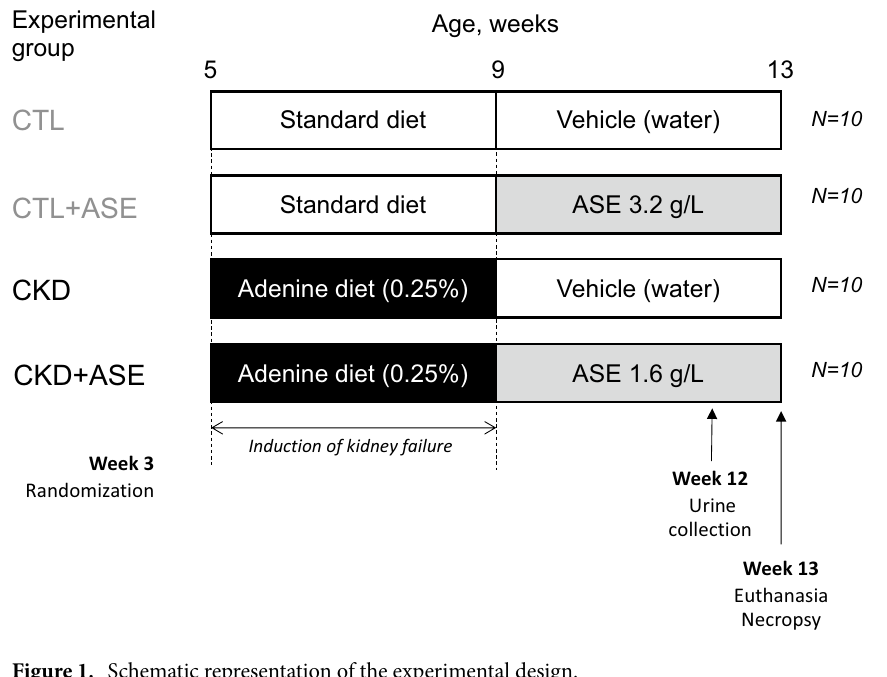
Figure 1. Schematic representation of the experimental